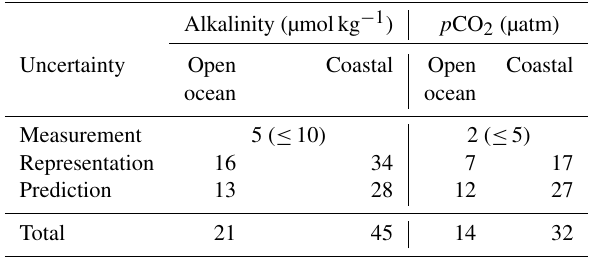
Table 3. Summary of the uncertainties of total alkalinity and p CO 2 from the different error sources (see Table 2) separately evaluated for the open ocean and for coastal regions (defined by the COSCATs regions, Laruelle et al., 2013). See text for details on how the different sources were